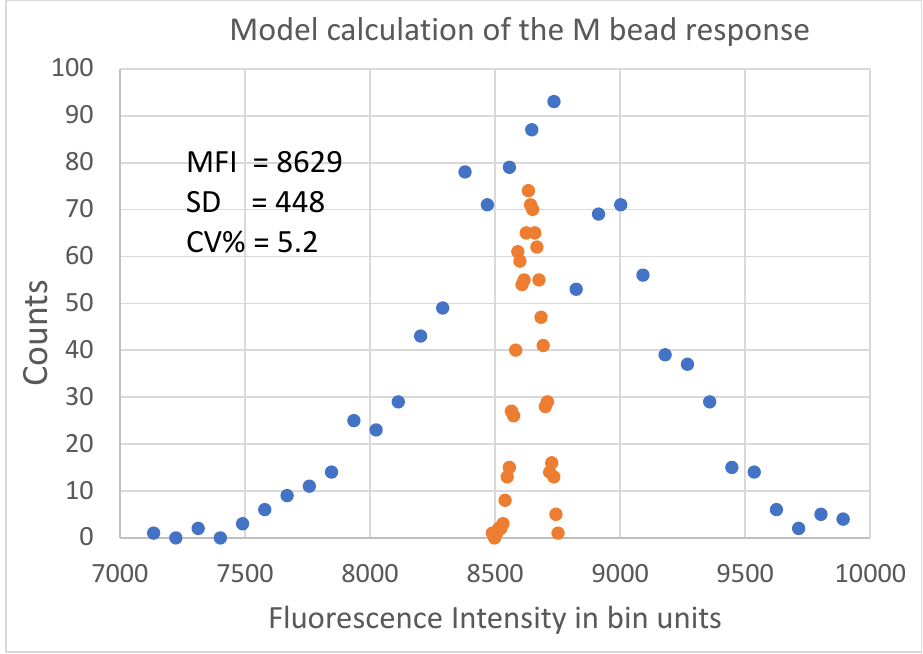
Figure 5. Histogram of the calculated heights of the digitized voltage pulses of 1024 M beads passing the laser beam. The horizontal axis plots the height of the pulse in bin unit and the vertical axis gives the number of times the height occurred. The bin values range between 1 and 65,536. Bead M occupies a small portion of the bin range and has an average height equal to about 8600 digital bin units. For the blue circles, the number of labels on the bead was 364 with a label SD of 19. For the orange circles, the number of labels on the bead was set to a constant value of 364. Clearly the variability of the number of labels on a bead is important.